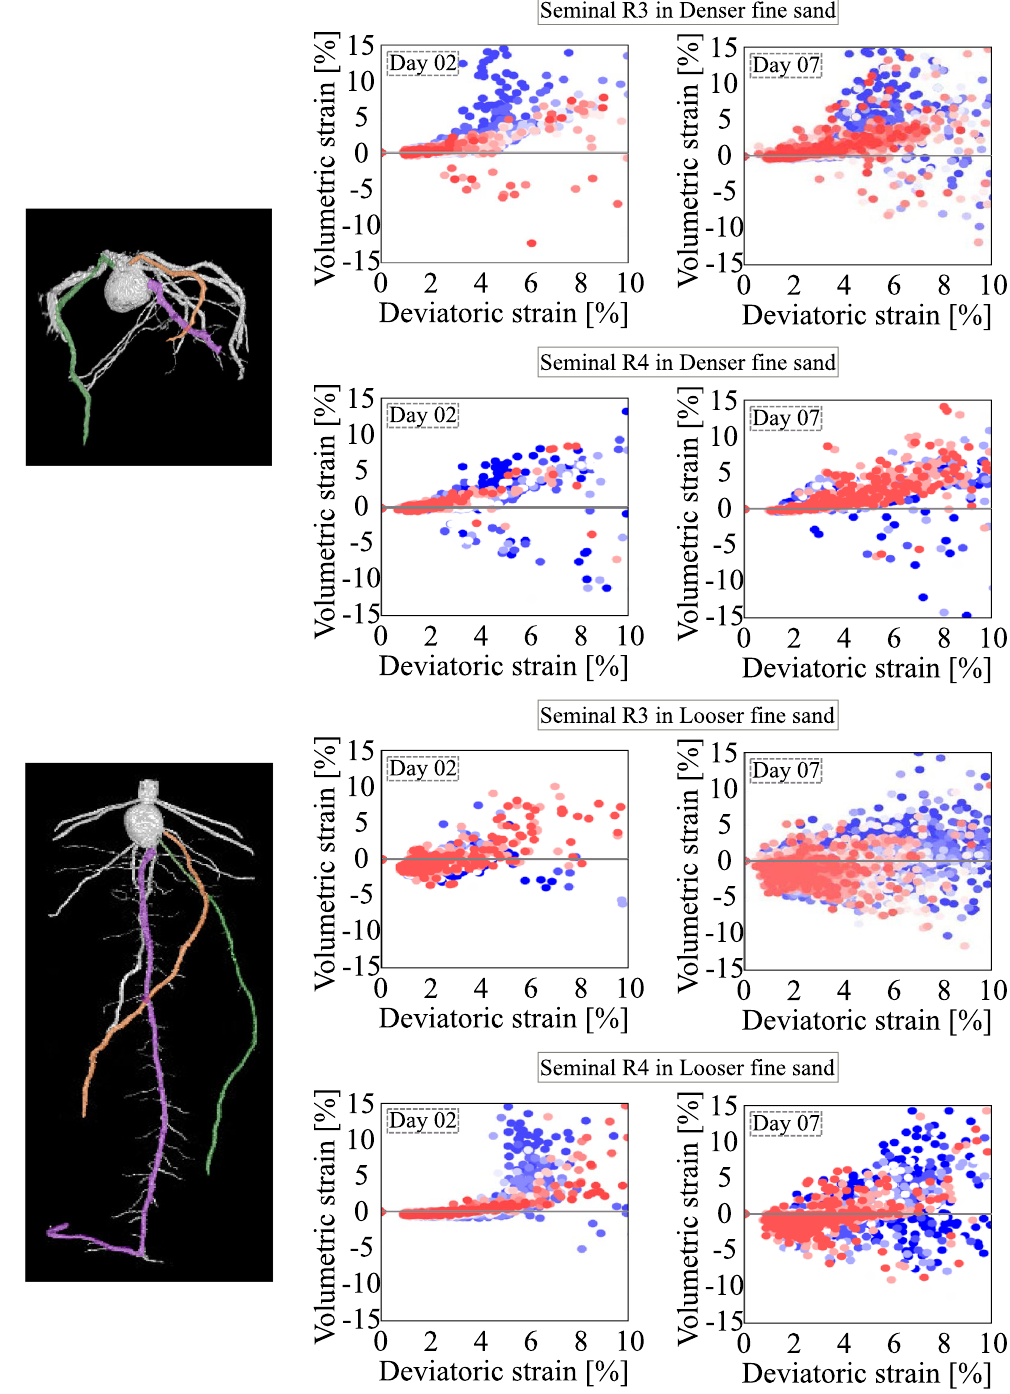
Figure 10. Plots of volumetric strain versus deviatoric strain in the vicinity of the seminal roots R3 (green) and R4 (orange) on Day 2 and Day 7. Blue dots (respectively, red dots) refer to points located in the immediate vicinity (respectively, further neighbourhood) of the roots. For reference, the primary root (R1) is highlighted in